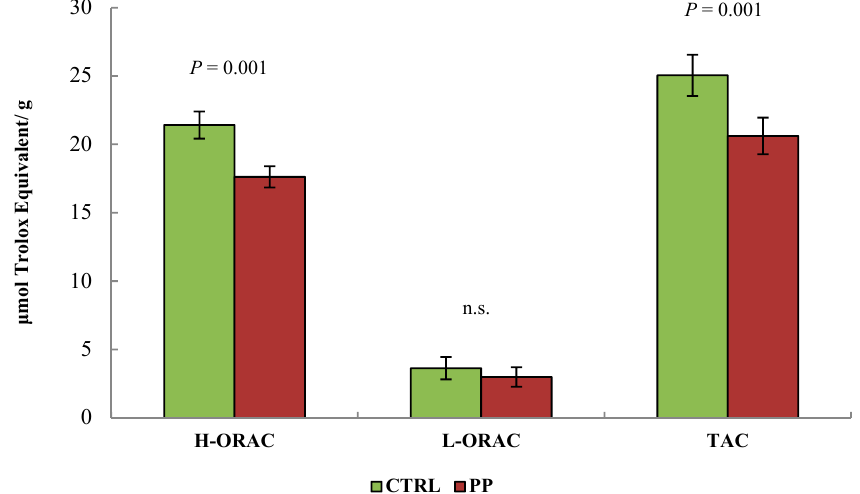
Figure 1. E ff ect of the inclusion of pomegranate pulp in the diet of lactating ewes on the antioxidant capacity of milk expressed as ( µ M Trolox Equivalent / g). CTRL = control concentrate, PP = concentrate containing 64% pomegranate pulp, H-ORAC = antioxidant capacity of milk hydrophilic fraction, L-ORAC = antioxidant capacity of milk lipophilic fraction, TAC = total antioxidant capacity of milk (H-ORAC +